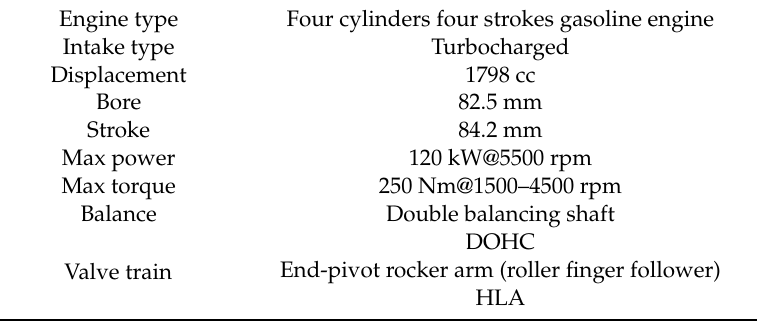
Table 1. Specification of the